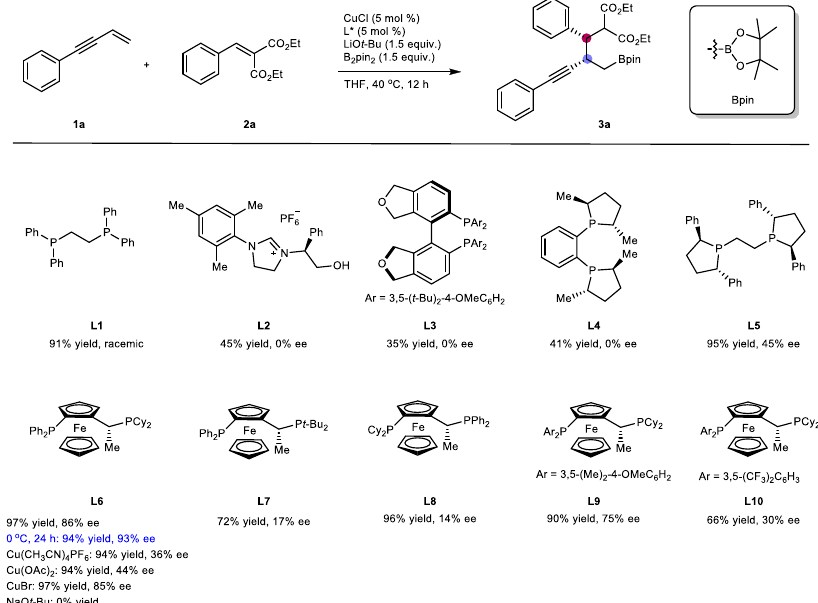
Fig. 2 Optimisation of coupling reaction conditions. All reactions were carried out in a 0.5 mmol scale using 1a (1.5 equiv.) and 2a (1.0 equiv.) under a N 2 atmosphere at 40 °C, unless otherwise noted. Yields of 3a are isolated and diastereomeric ratio of product 3a was determined via 1 H NMR analysis of the unpuri fi ed mixtures and was high (>98:2) in all cases. B 2 pin 2 =